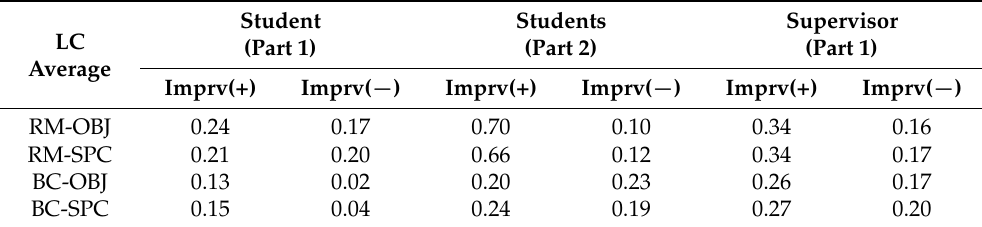
Table 7. Improvement Index for LC Project (Part 1 and